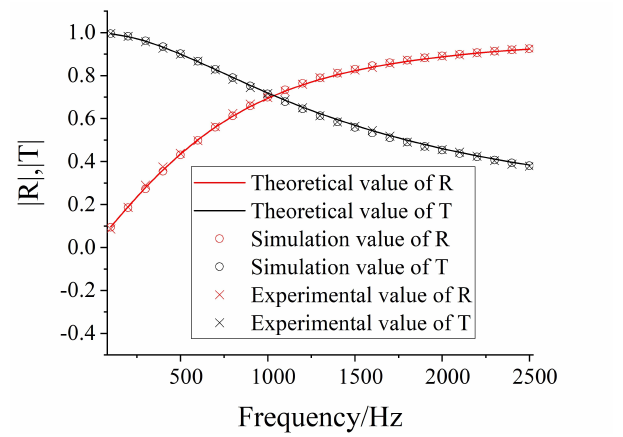
Figure 18. Comparison of the theoretical, the simulation values and experimental values of reflection coefficient (R) and transmission coefficient (T), when there is a steel sample in the impedance